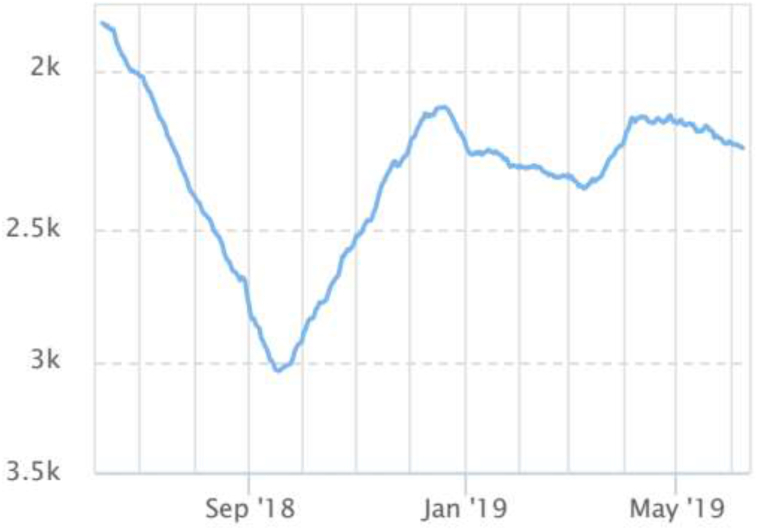
This figures depicts the ranking of websites over 6 months duration relative to other websites.